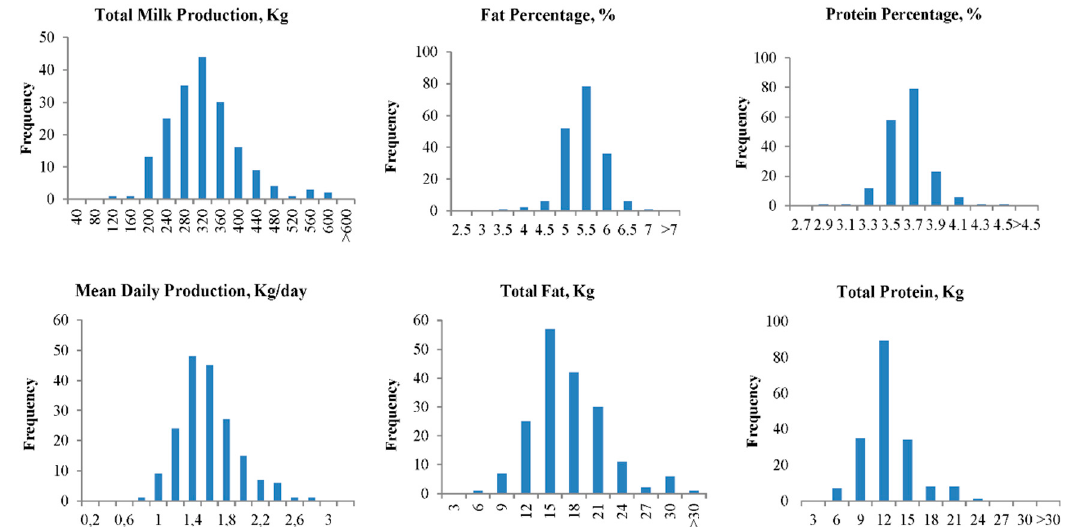
Figure 2. Frequency histograms for the variables studied across farms.